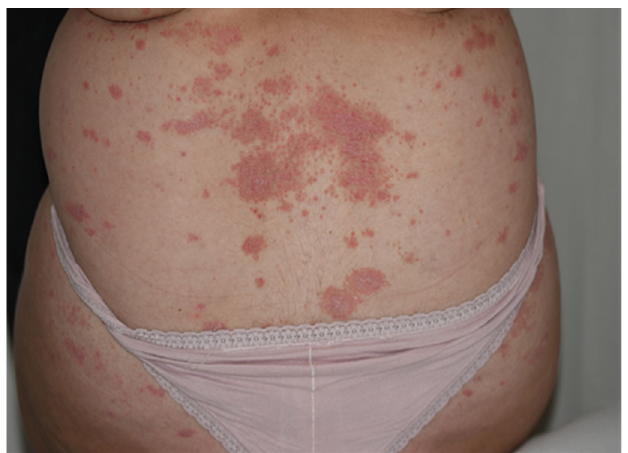
Figure 1. Psoriasis Vulgaris after use of keratolytic agents: skin plaques located on the lower back. Guttate psoriasis—some adolescents who become pregnant can develop an acute, self-limiting form of psoriasis known as guttate psoriasis (from the Latin gutta , meaning ‘droplet’). In this form of psoriasis, papules less than 1 cm in diameter erupt on the trunk about 2 weeks after a β -hemolytic streptococcal infection such as tonsillitis or pharyngitis, or a viral infection.